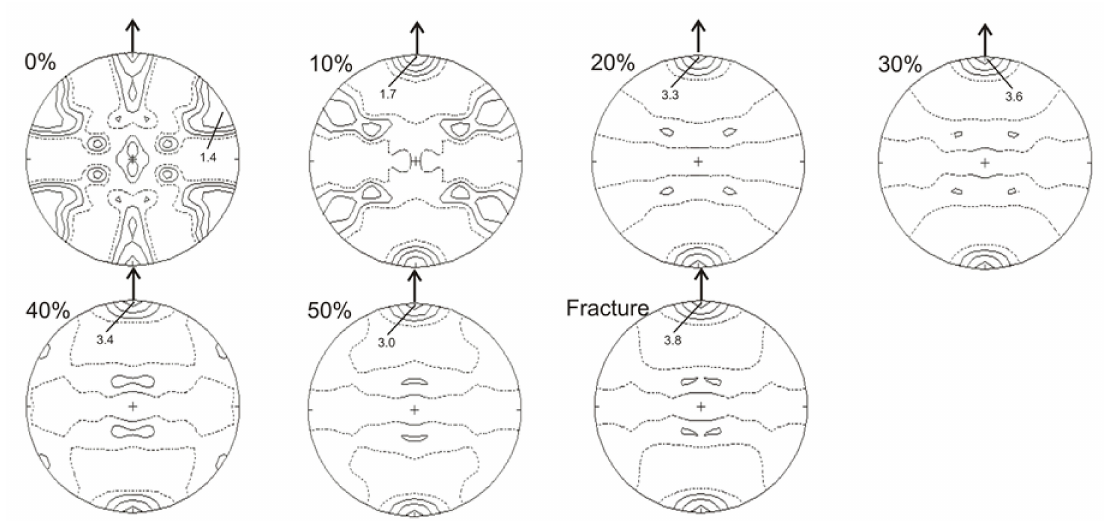
Figure 5. Calculated pole figures for austenite {111} in the initial state (0%) and after selected deformation